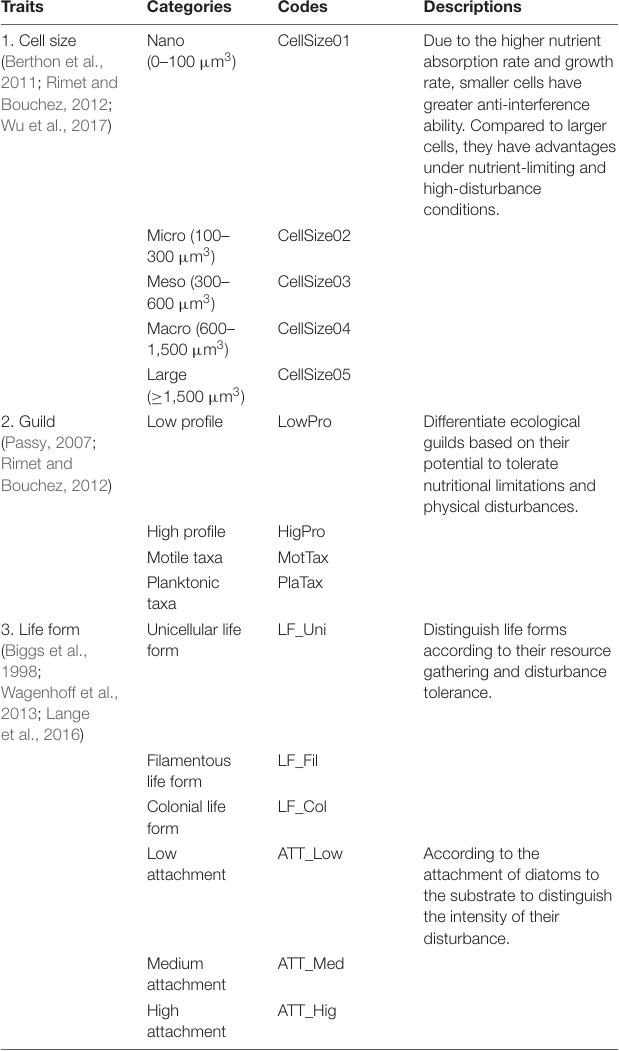
TABLE 1 | Diatom traits, their categories, codes, and descriptions used in this